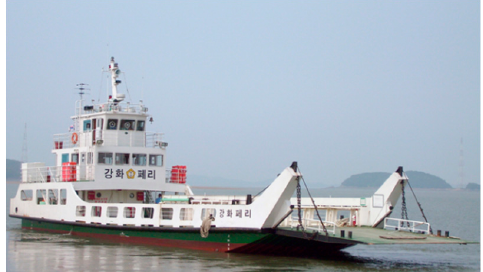
Table 1. Case ship and its specifications (courtesy of Hallym Shipping Ltd., 15, Eogokgongdan 5-gil, Yangsan-si, Gyeongnam, Korea).